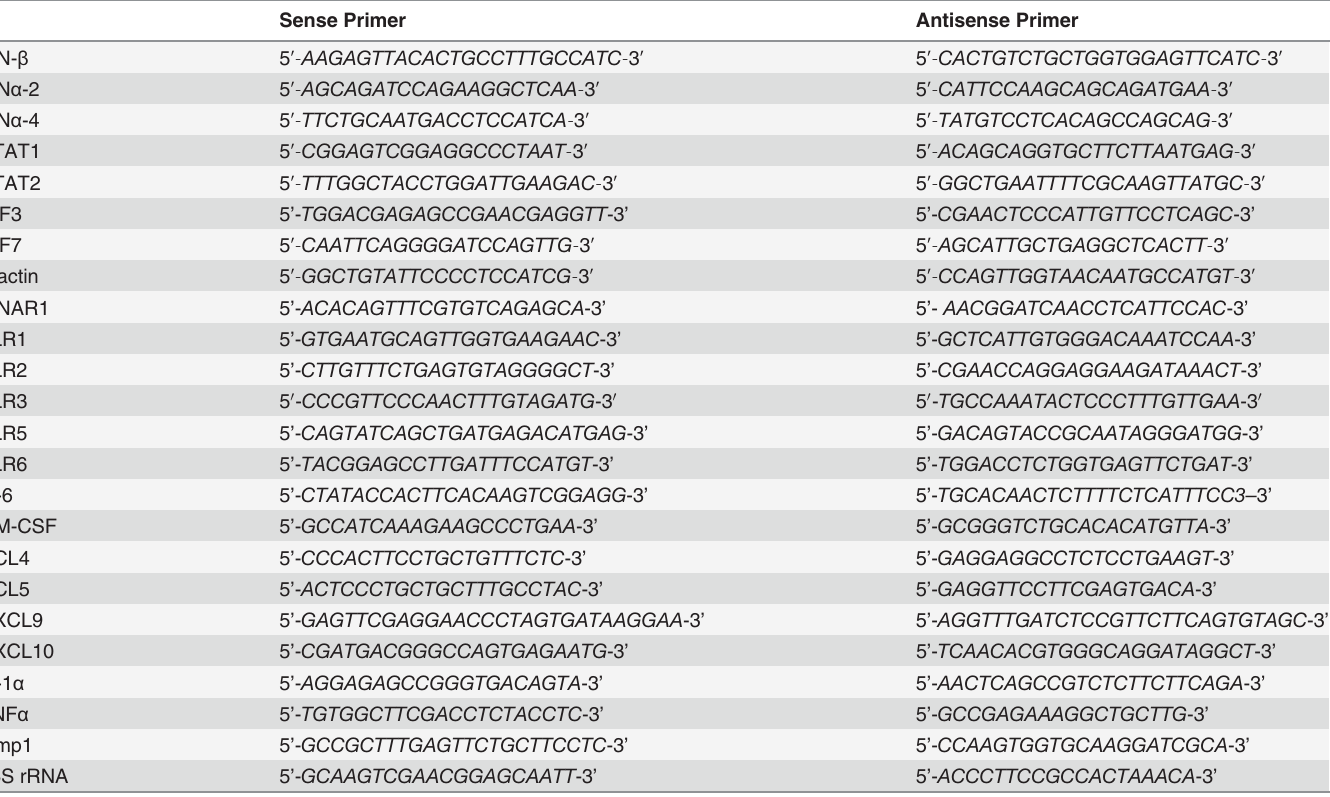
Table 1. Primers for